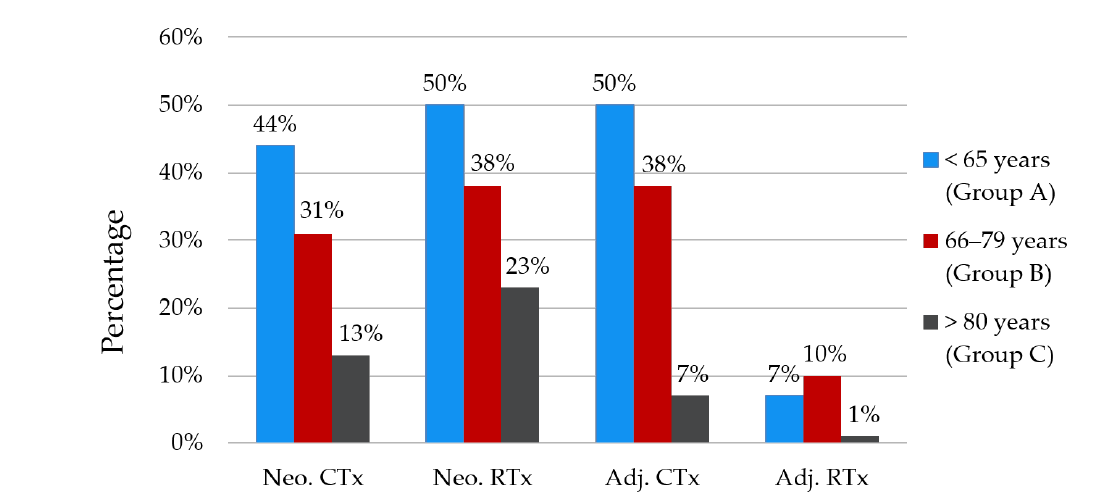
Figure 1. Percentage of patients with rectal cancer that received either neoadjuvant or adjuvant chemoradiotherapy concurrent with surgery. Differences between each age group within each category were significant ( p < 0.05). Adj. = adjuvant, CTx = chemotherapy, Neo. = neoadjuvant, RTx =